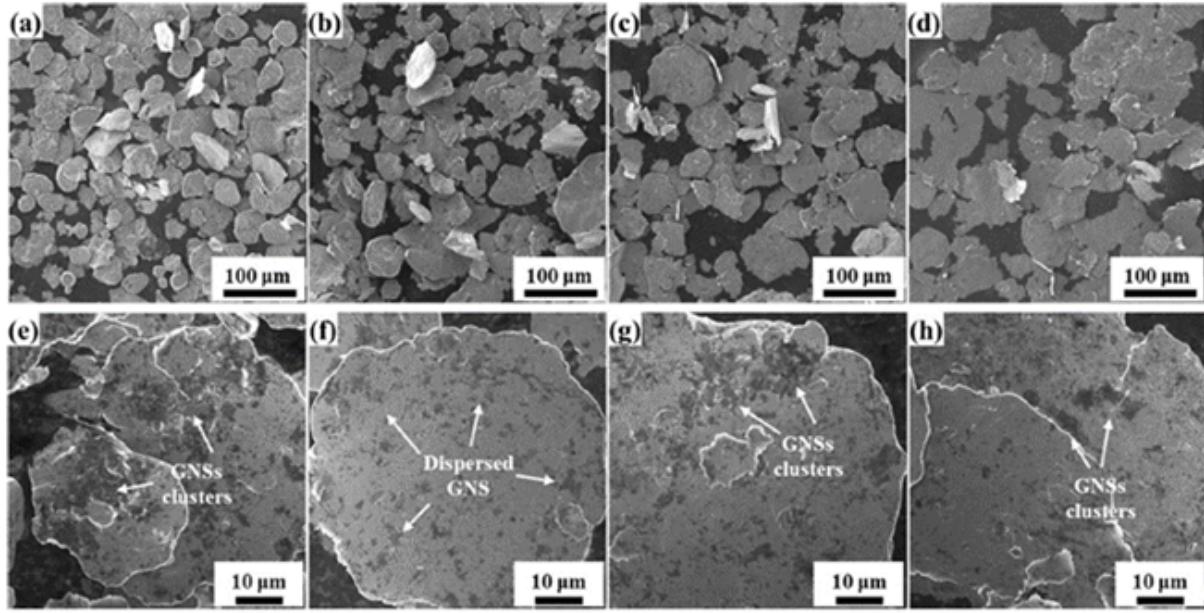
Figure 9: SEM images of GNS/Al flakes after low-speed milling (a, e) 4 h, (b, f) 6 h, (c, g) 8 h, (d, h) 10 h. Reproduced from Reference [95].